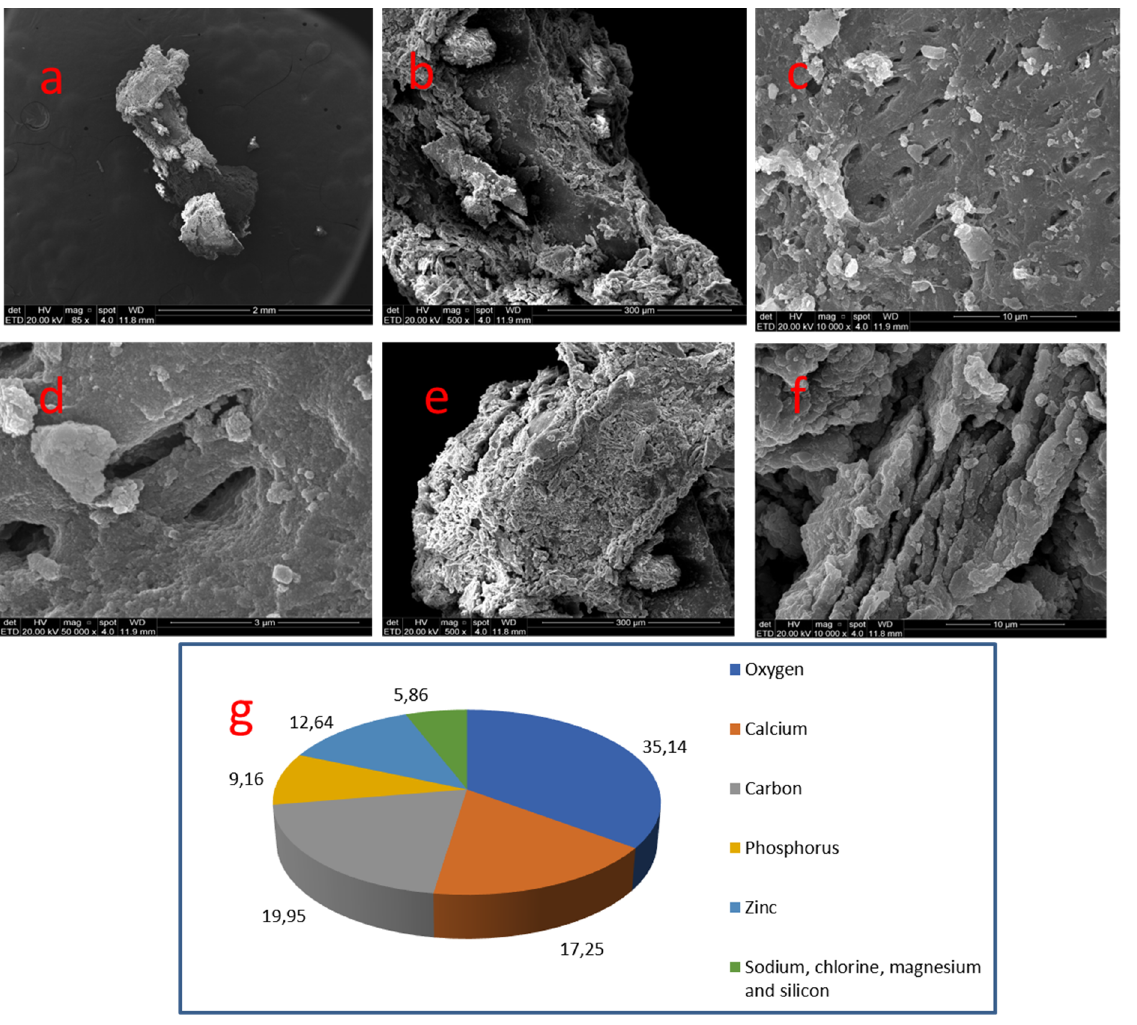
Figure 4. Sample 02: ( a ) irregular topography (SEM, 85×); ( b ) Irregular areas, with little areas of smooth and compact surface (arrow) (SEM, 500×); ( c ) Pores along the smooth surface (SEM, 10.000×); ( d ) Spherical crystalizing pattern (SEM, 50.000×); ( e ) Nodule pole with very irregular surface (SEM, 500×); ( f ) Crests and depressions (SEM, 10.000×); ( g ) Results of chemical analysis of the sample with X-ray dispersive energy spectroscopy (EDX).